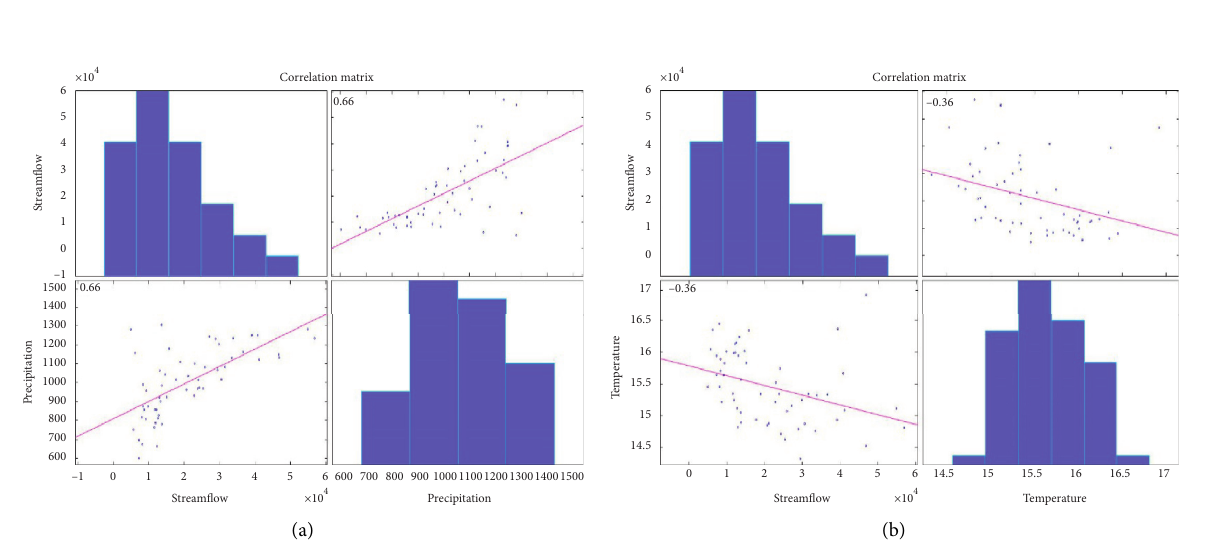
Figure 6: Correlation matrix: (a) between precipitation and stream flow and (b) between temperature and